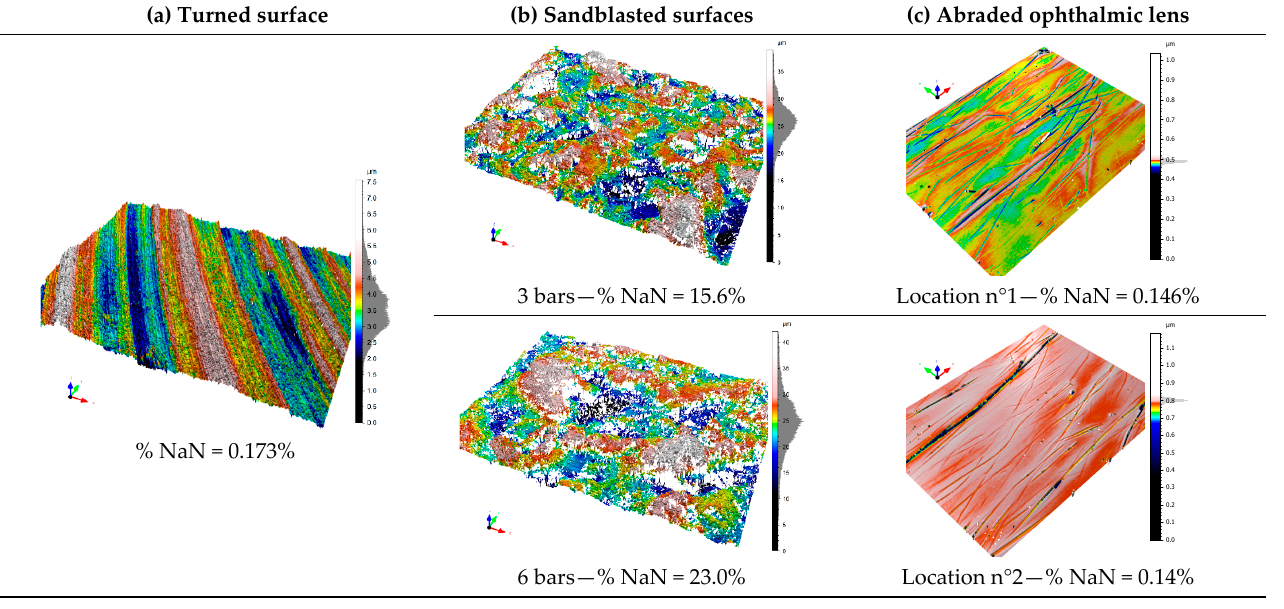
Figure 3. Locations of the two measured regions on the biplane ophthalmic lens.